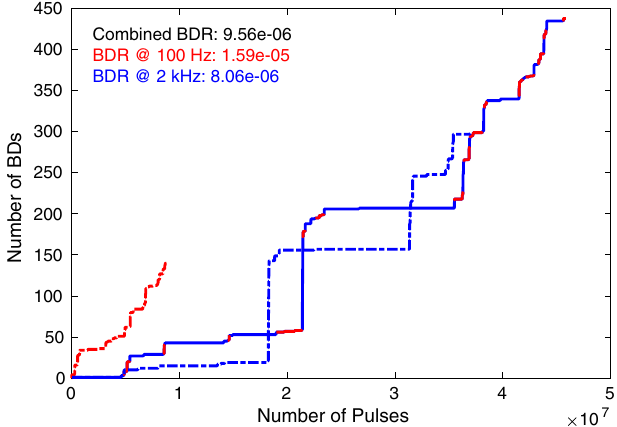
FIG. 7. Evolution of the cumulative number of BDs against the number of high-voltage dc pulses with the swapping of repetition rates. The solid line shows the result from the whole experiment, while the blue and red dash-dotted lines show the results for the repetition rates of 2 kHz and 100 Hz, respectively.